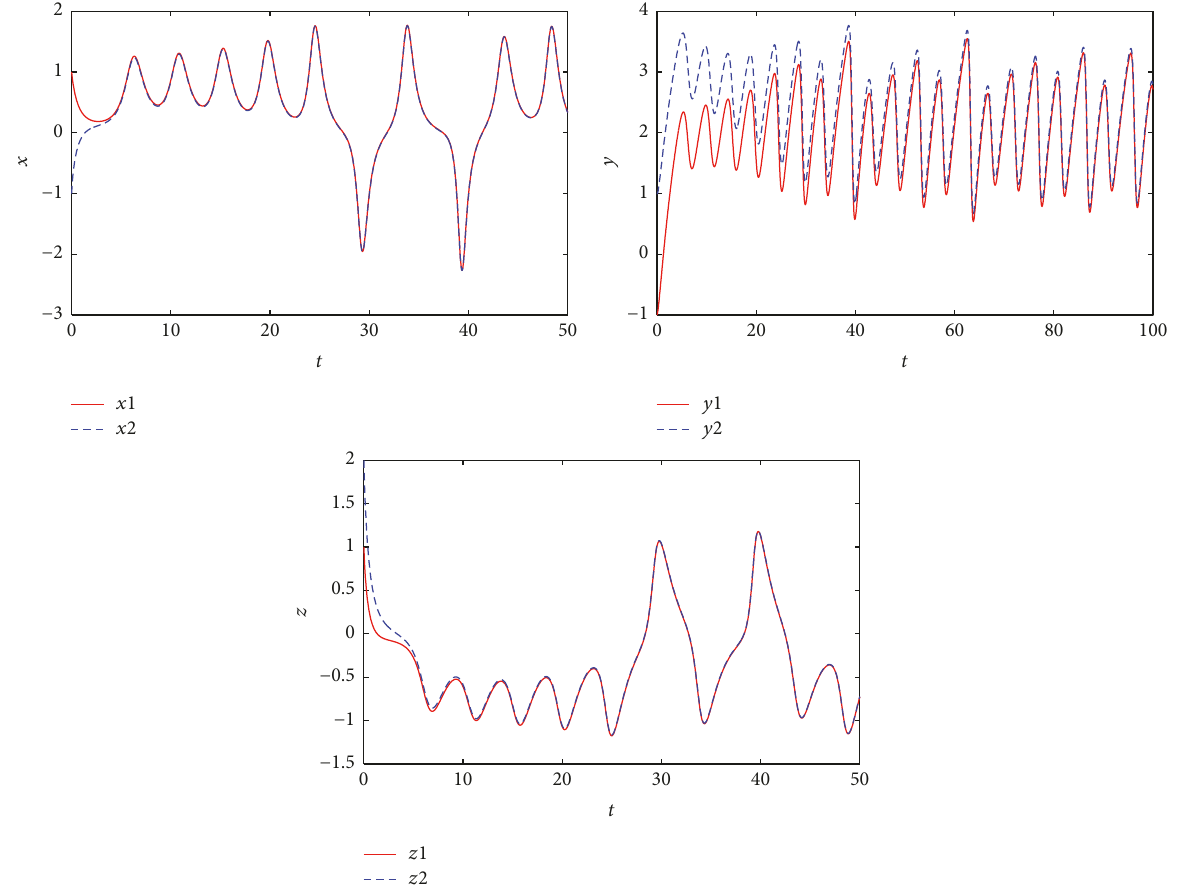
Figure 1: Synchronization of states of two financial FOSs with parameters 𝑎 = 1 , 𝑏 = 0.1 , 𝑐 = 1 , and 𝛼 = 0.87